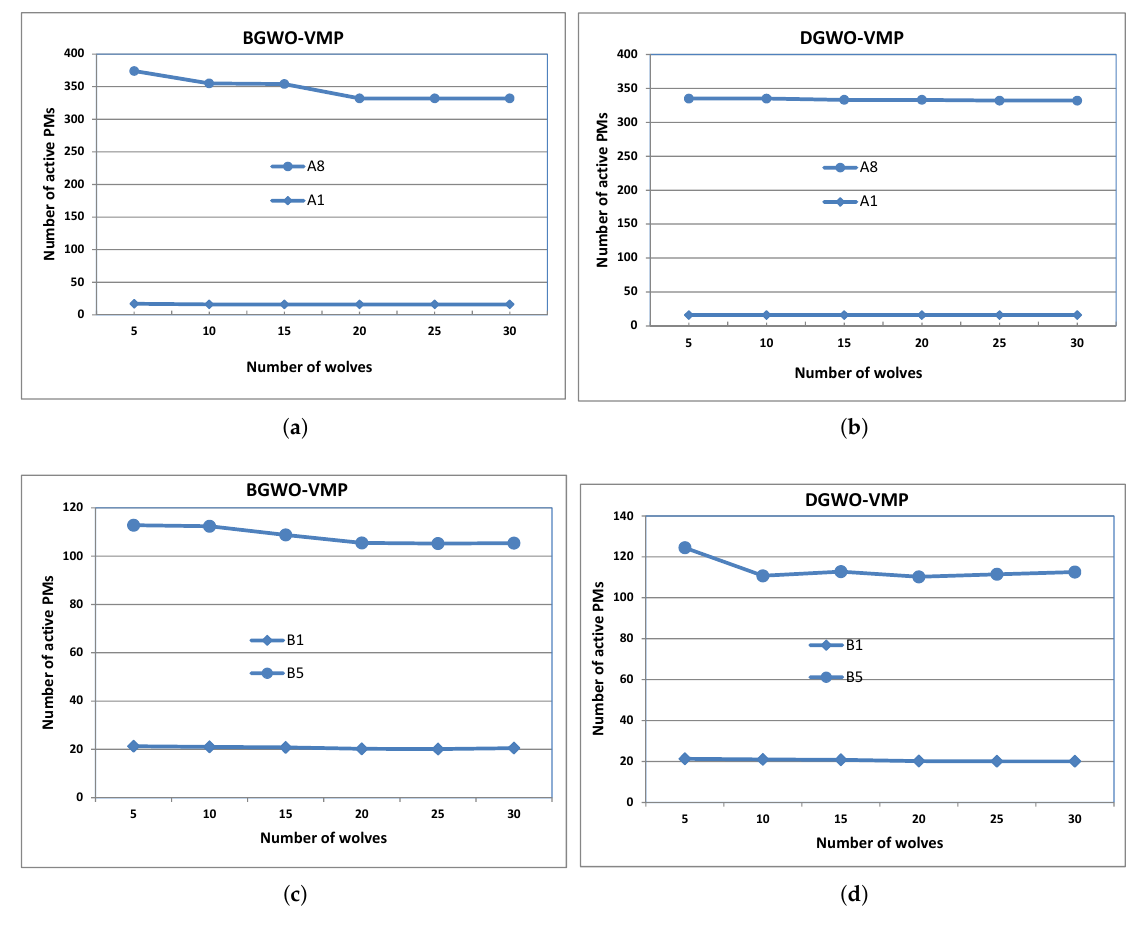
Figure 9. Influence of the number of wolves in BGWO-VMP and DGWO-VMP for both homogeneous and heterogeneous environments. ( a ) Homogeneous BGWO-VMP; ( b ) Homogeneous DGWO-VMP; ( c ) Heterogeneous BGWO-VMP; ( d ) Heterogeneous